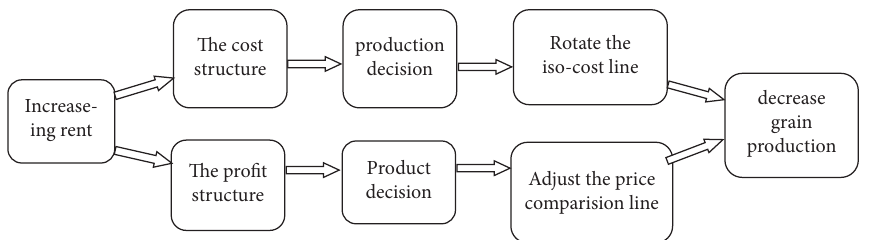
Figure 3: Abridged view of the impact mechanism on grain production by farmland transfer rent.